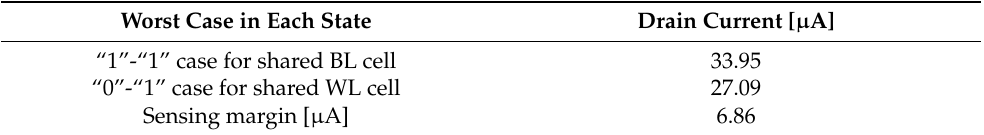
Table 3. Read current values of the worst case in each state at 10 ns after application of the read voltage.